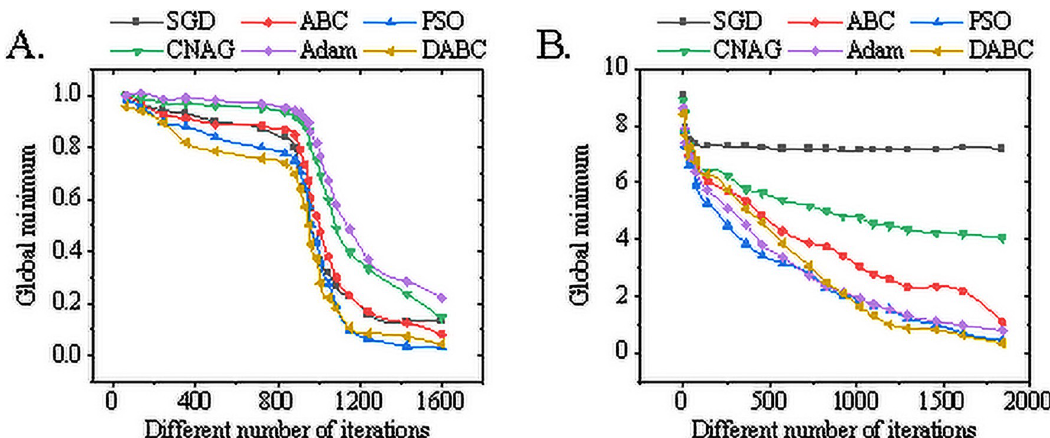
Fig 7. Results of searching performance of the improved NAG algorithm on Sphere function and Griewank function. Note: Fig 7-A represents the results on Sphere function; Fig 7-B represents the results on Griewank function.